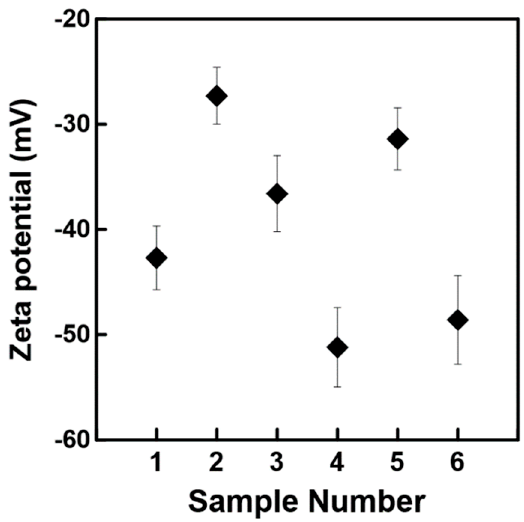
Figure 5. Zeta potential measurement of samples 1–6 in Figure 3.